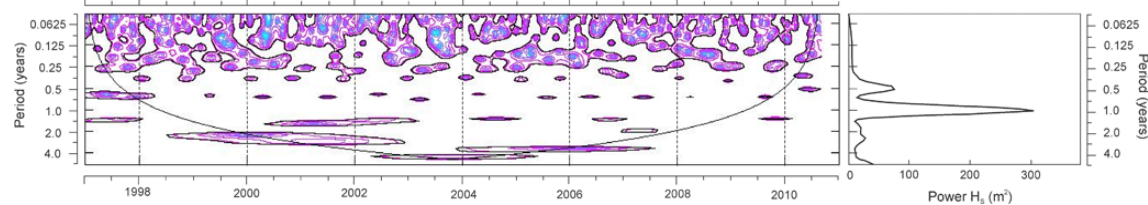
Fig. 15. Continuous wavelet transform spectrum (left) and global wavelet spectrum (right) for H s of the virtual